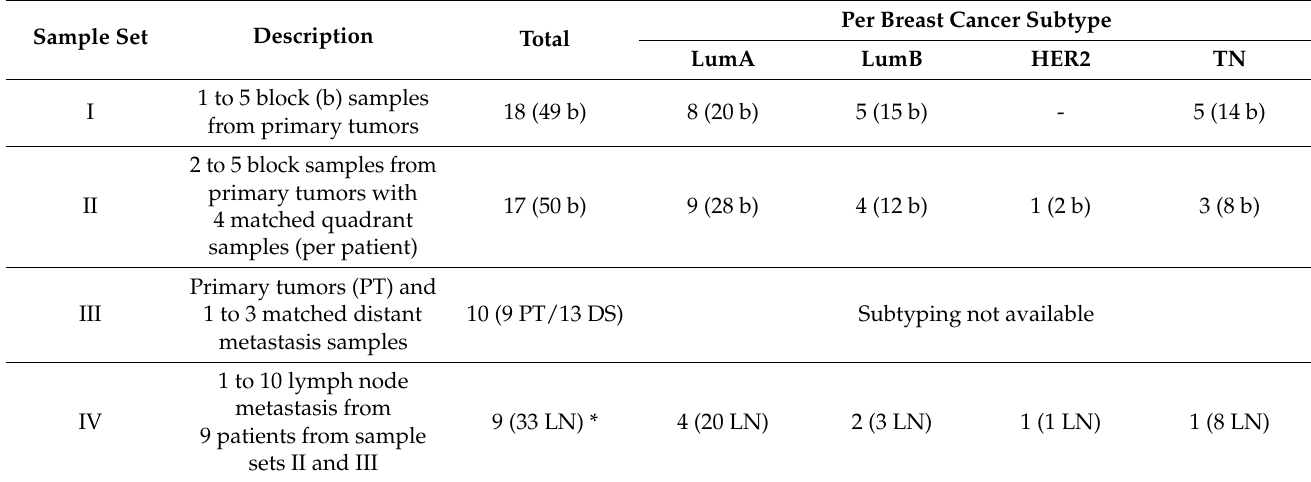
Table 1. Summary description of sample sets used. The total number of patients and number of patients per subtype are given. Between brackets are the corresponding number of samples and their type; b: Primary tumor tissue block sample, PT: primary tumor sample, LN: lymph node metastasis sample, DS: distant site metastasis sample. Detailed description is given in the Supplementary Materials Information (Supplementary Information,